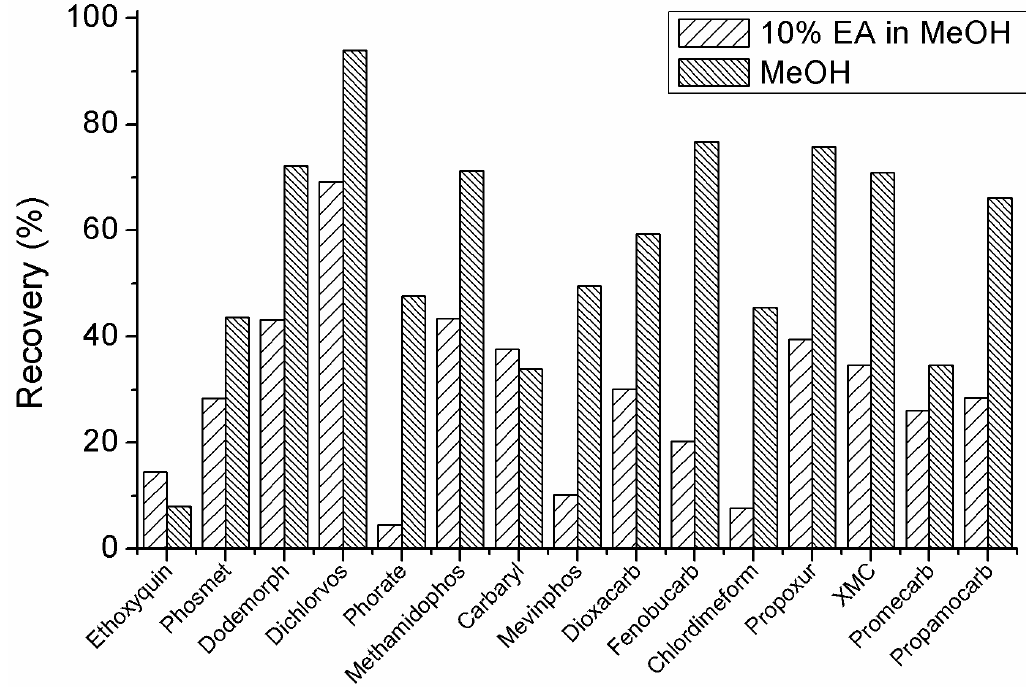
Figure 3. Recoveries of typical compounds with or without the use of 10% ethyl acetate in the methanol.